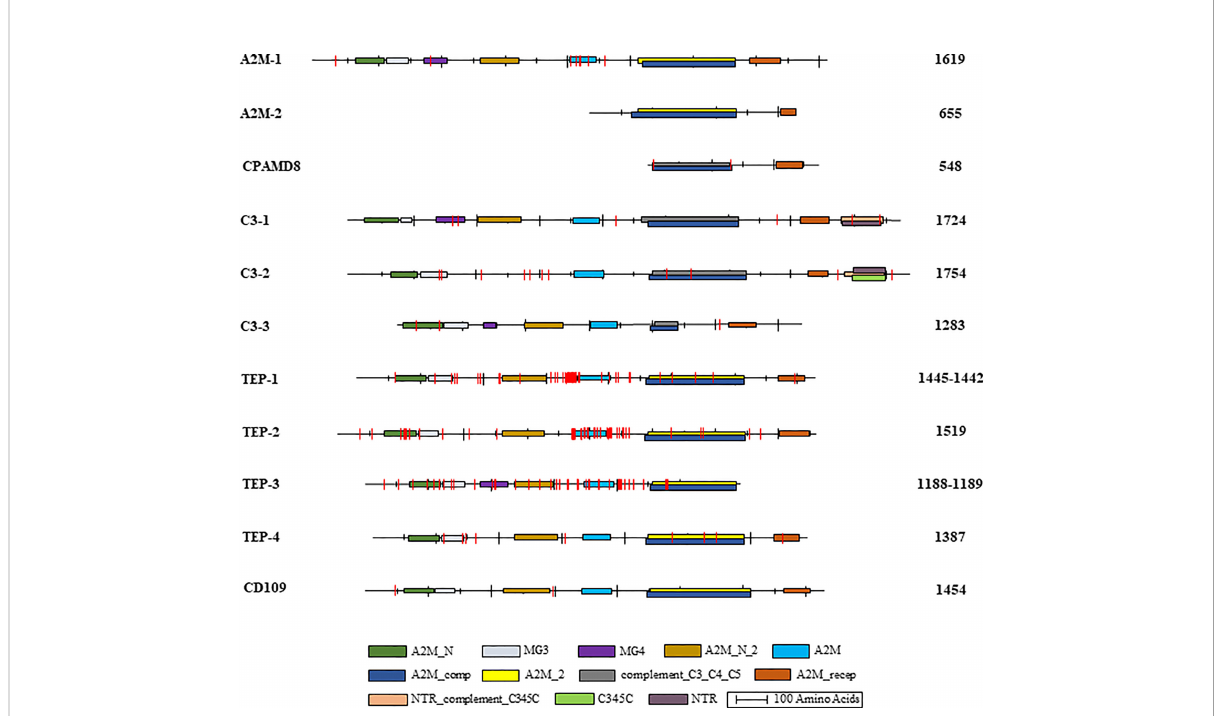
FIGURE 2 B. glabrata TEP structural domains and single amino acid mismatches. Graphical representation of the identi fi ed conserved domains in aligned B. glabrata BB02 and BS90 TEP amino acid sequences. The National Center for Biotechnology Information (NCBI) Conserved Domain Database (CDD) (63; http://www.ncbi.nlm.nih.gov/cdd) was utilized to localize TEP domains following their nomenclature and abbreviations: A2M_N = MG2 (macroglobulin) domain of alpha-2-macroglobulin; MG3 = macroglobulin MG3 domain, corresponds to the MG3 domain found in complement components C3, C4 and C5; MG4 = macroglobulin MG4 domain, found in complement C3 and C5 proteins; A2M_N_2 = Alpha- 2-macroglobulin family N-terminal region; A2M = Alpha-2-macroglobulin family, includes the C-terminal region of the alpha-2-macroglobulin family; A2M_comp = Complement component region of the alpha-2-macroglobulin family; A2M_2 = Proteins similar to alpha-2- macroglobulin (alpha (2)-M). This group also contains the pregnancy zone protein (PZP), thioester region located within the structure; complement_C3_C4_C5 = Proteins similar to C3, C4, and C5 of vertebrate complement, thioester region located within the structure of C3 and C4; A2M_recep = Receptor domain region of the alpha-2-macroglobulin family; NTR_ complement_C345C = NTR/C345C domain, NTR domains found in the C-termini of complement C3, C4, and C5; C345C = Netrin C-terminal Domain; NTR = UNC-6/NTR/C345C module, sequence similarity between netrin UNC-6 and C345C complement protein family members. The intervals of each domain and the length of each sequence are illustrated to scale. BB02 and BS90 TEP-1 and TEP-3 had different sequence lengths, so both are listed with BB02 fi rst and BS90 second. The vertical red lines represent the relative location of amino acid